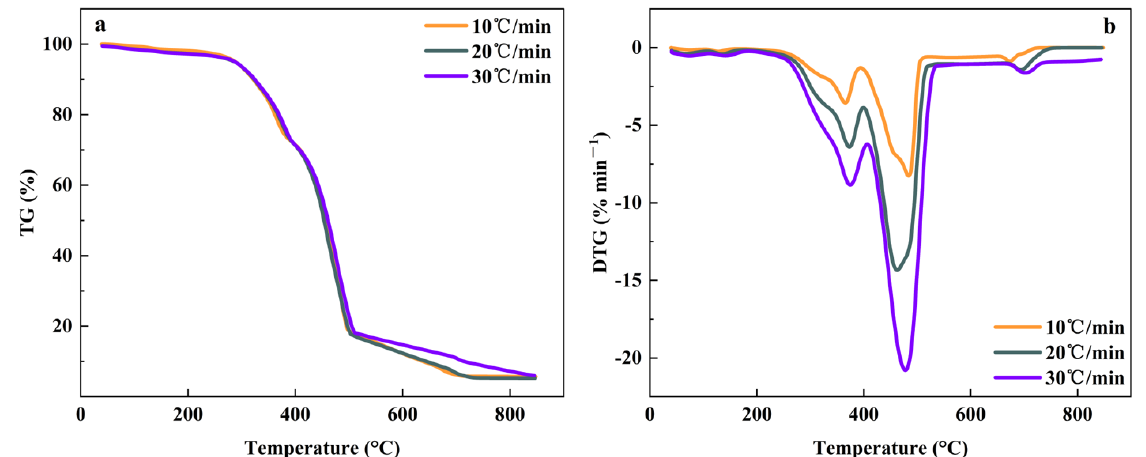
Figure 5. ( a ) The TG curves of co-pyrolysis of MS and PP at different heating rates; ( b ) The DTG curves of co-pyrolysis of MS and PP at different heating rates.